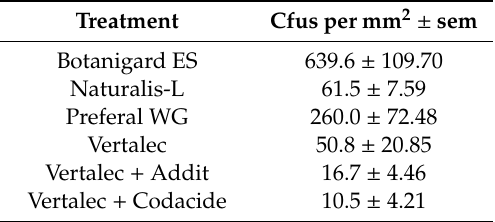
Table 3. Mean number of colony forming units (cfus) per mm 2 ( ± standard error of the mean) of EPF biopesticides applied to adult aphids in laboratory bioassays.